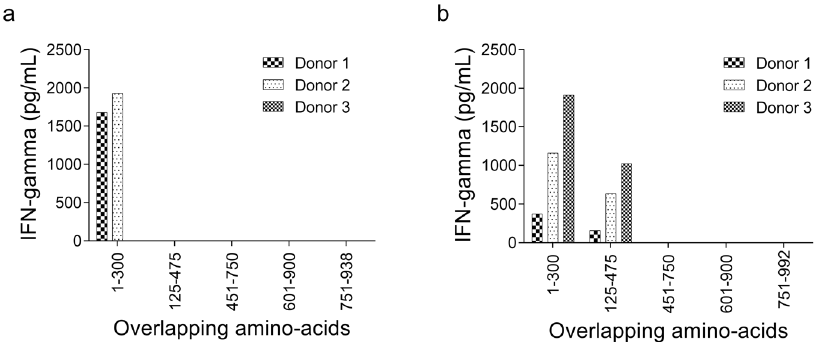
Fig. 5 Minigene screening for the identi fi cation of an HLA-B*57:01 restricted EBNA3C epitope. a EBNA3C and ( b ) EBNA3B full-length ORFs were truncated and cloned into pDEST103 as overlapping minigenes. Minigenes were co-transfected into Cos-7 cells along with HLA-B*57:01. Data are CD8 T cell responses (IFNg production) from the T LCL lines from three donors (Donor 1 – 3). x -axes represent the location of fi rst and last amino acids of the minigene polypeptide sequence.